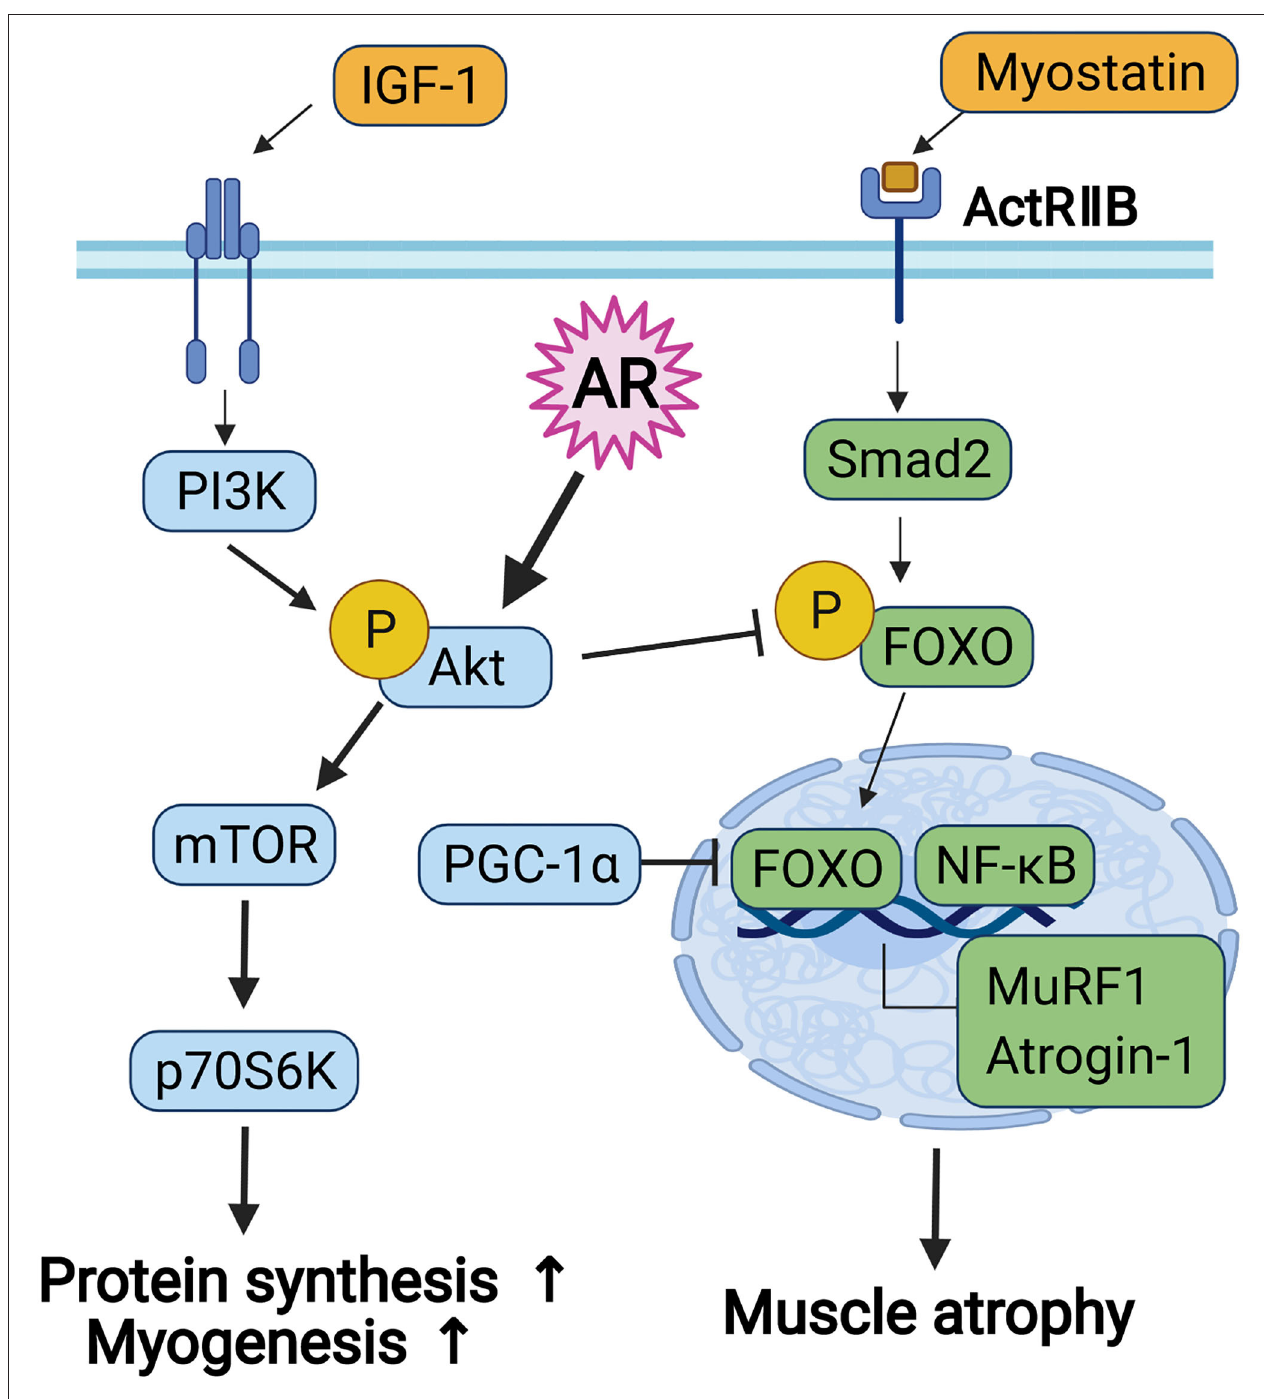
FIGURE 6 | The diagram for the signaling pathway concerned to myoblast differentiation and protein metabolism.